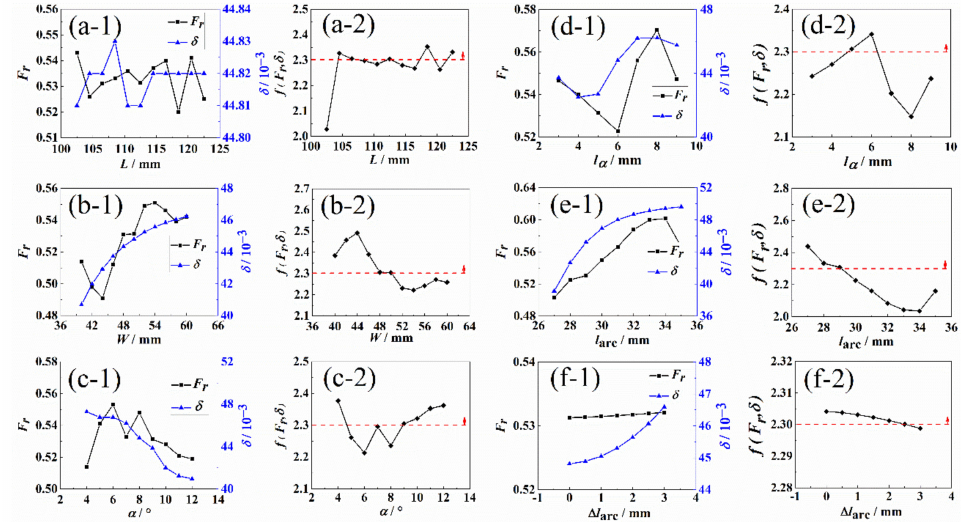
Figure 4. The relationship between the ( a-1 – f-1 ) stress concentration factor F r , stress variation coefficient δ and ( a-2 – f-2 ) the weighted design function f ( F r , δ ) and ( a ) the length of loading arms L , ( b ) The width of loading arms W , ( c ) The necking angles α , ( d ) the distance between necking angle and transition area l α , ( e ) center region of transition arc l arc , ( f ) eccentricity of the effective test region ∆ l c . The red dash line and arrow indicate the allowable